Question: Identify the chart type used in this figure.
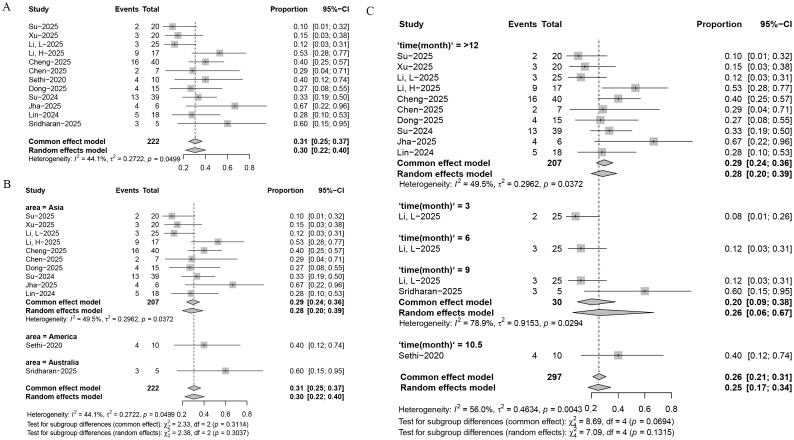
Answer: forest